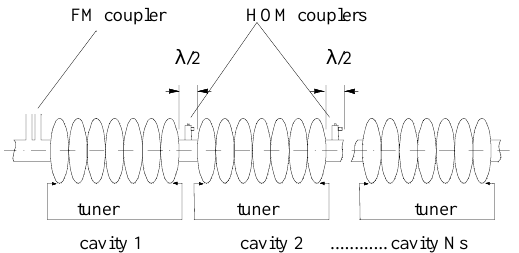
FIG. 4. (cid:107) (cid:115)(cid:115) for different mode groups in the superstructure based on a 9-cell cavity with a 110 mm beam